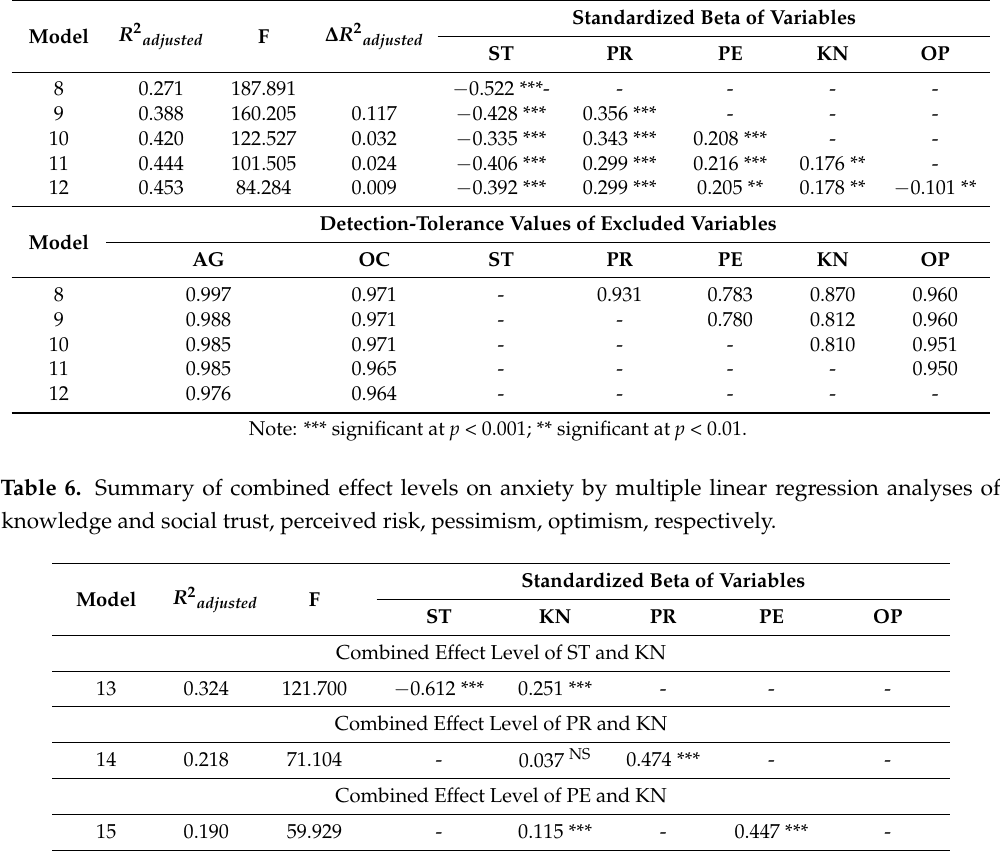
Table 5. Summary of combined and relative effect levels on anxiety by stepwise regression analysis of age, occupation, social trust, perceived risk, optimism, knowledge, and pessimism.